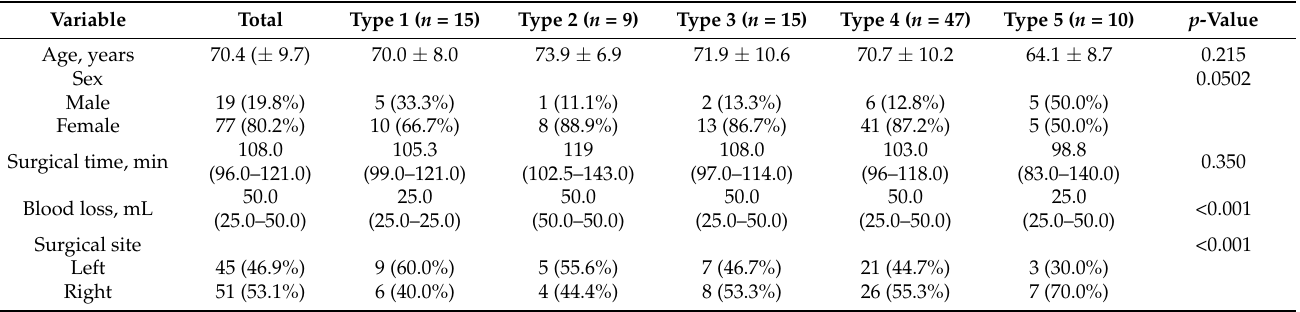
Table 1. Base information of study population and comparison between five types of phenotypes by Huang’s